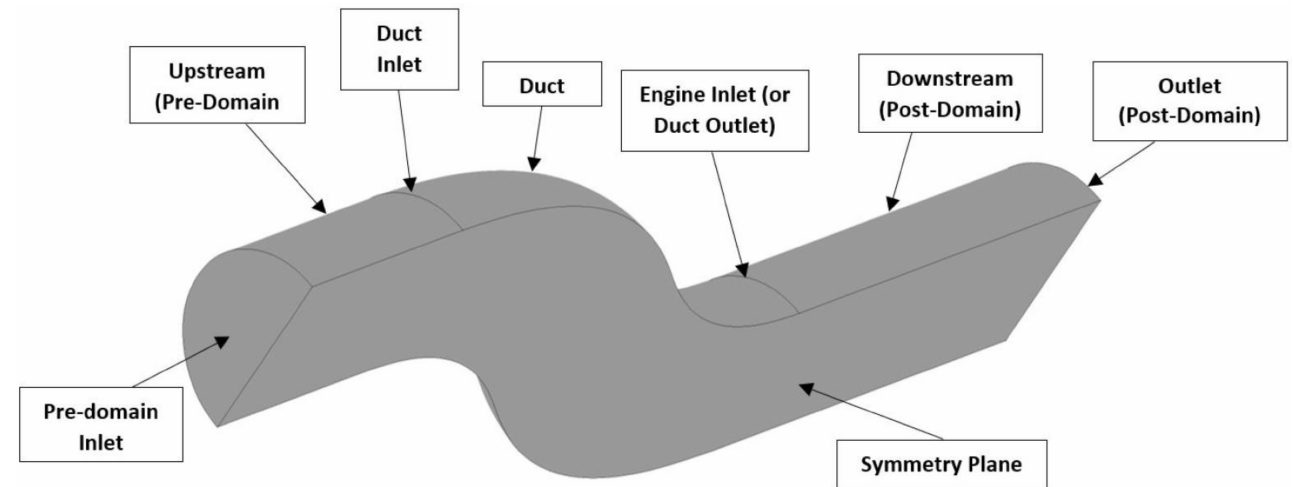
Figure 5. A 3D rendering of the S-duct domain for CFD